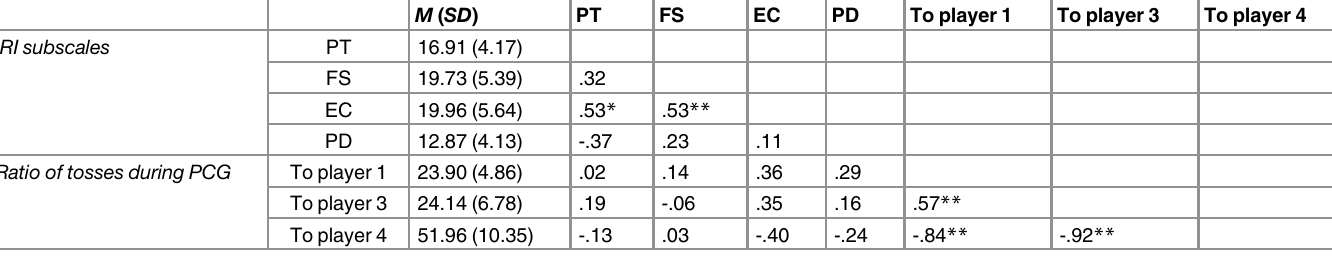
Table 2. Correlations between behavior during the exclusion game and self-reported empathy.